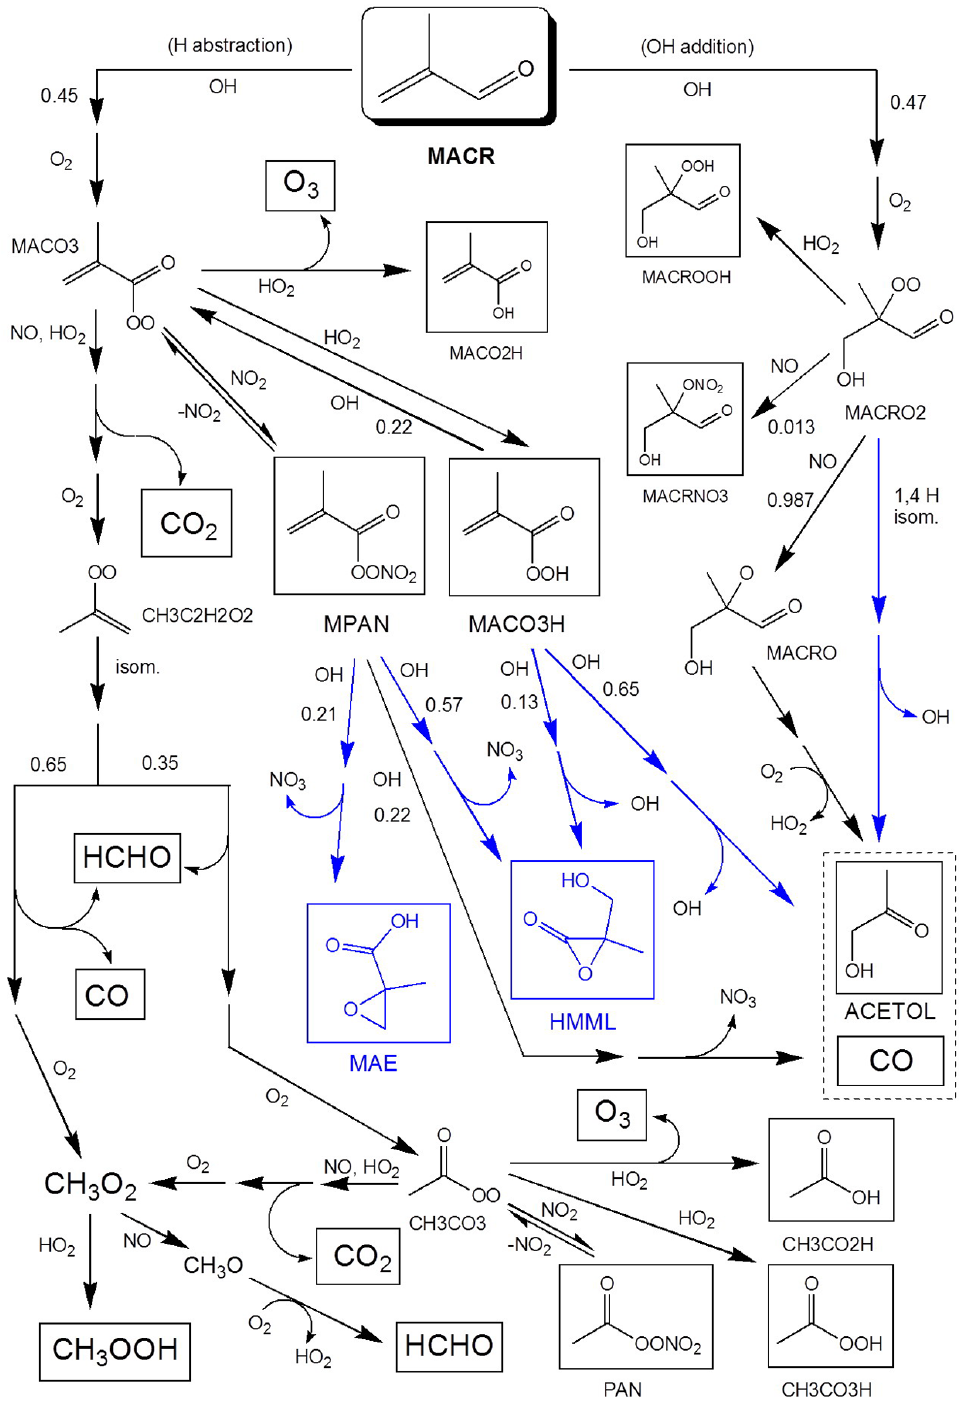
Figure 6. Schematic of the main features of the mechanism following reaction of OH with methacrolein (MACR), as represented in MCM v3.3.1. For clarity, the chemistry of the minor (8%) OH addition channel and the reactions of the intermediate peroxy radicals with NO 3 and the peroxy radical pool are not shown. Species in solid boxes are oxygenated end products. Species and routes shown in blue are new in MCM v3.3.1. The further chemistry of MPAN and MACO3H is also shown to illustrate newly implemented